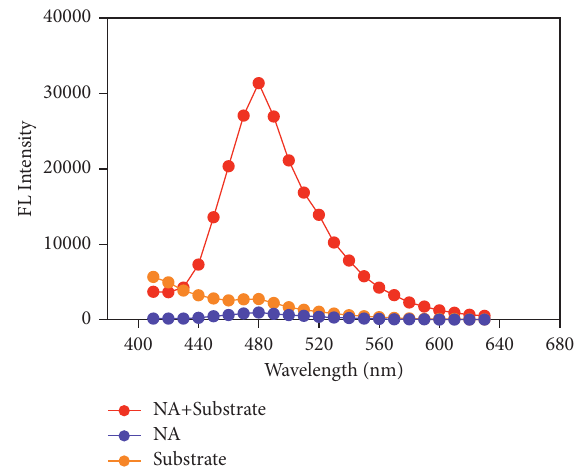
Figure 2: Fluorescence spectra under emission wavelengths at 410–630nm and excitation at